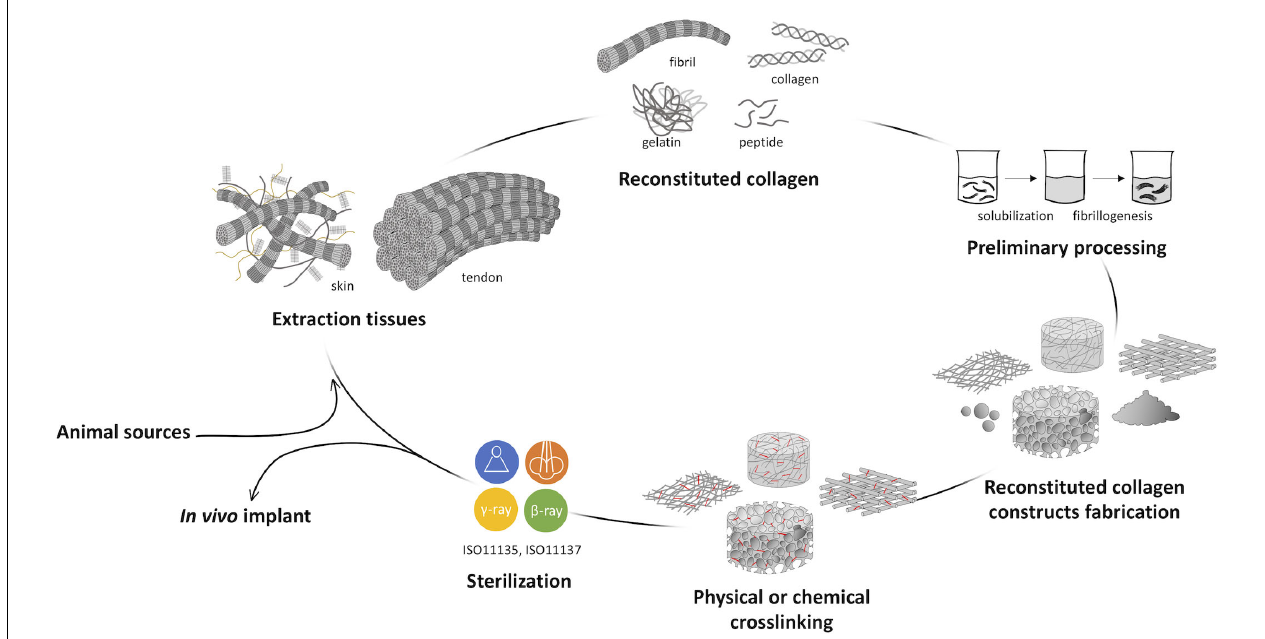
FIGURE 3 | Representative scheme of collagen processing steps from the animal source harvesting to the in vivo implant. The development of a collagen-based product can be divided into five macro steps: (i) the extraction or isolation from animal tissues, (ii) the preliminary raw material processing, (iii) the fabrication of the collagen-based product, (iv) its customization by the application of physical and/or chemical crosslinking, and (v) the final sterilization.